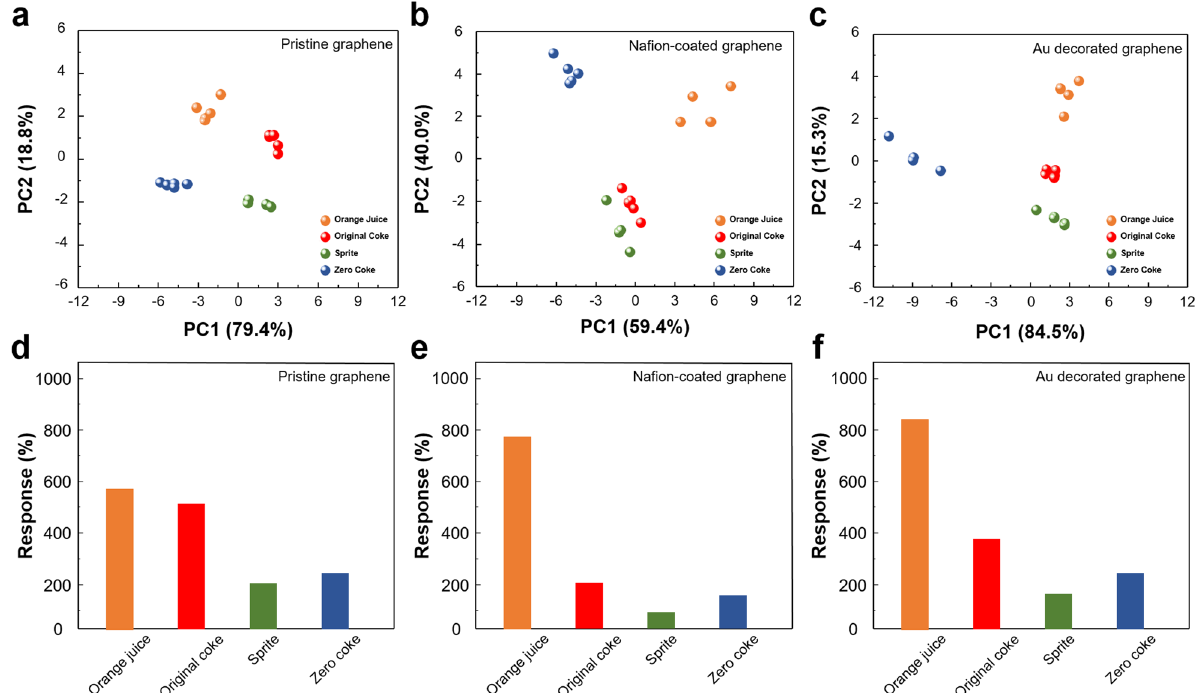
Fig. 7 PCA plots and responses to real beverages of the three types of SFETs. PCA plots and response comparison a , d pristine graphene, b , e Na fi on-coated graphene, and c , f Au-decorated graphene, respectively, to four real beverages (orange juice, original coke, Sprite, and zero coke).